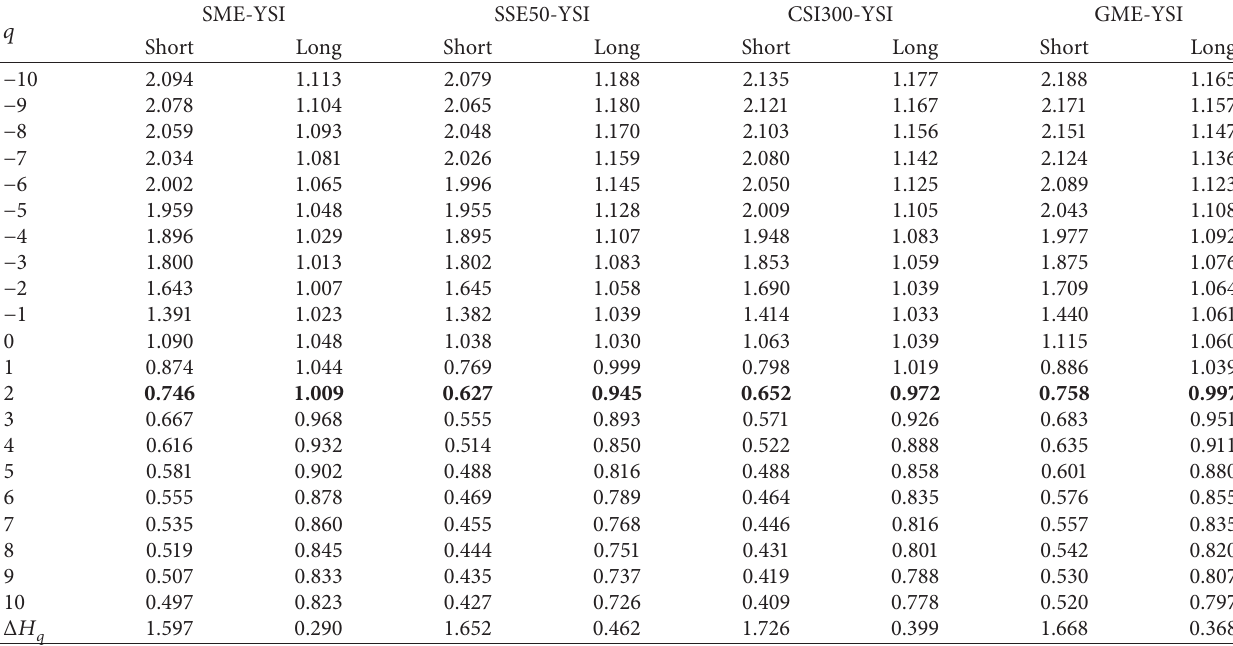
Table 9: Results of the short-term and long-term scaling exponents for Chinese stock market returns